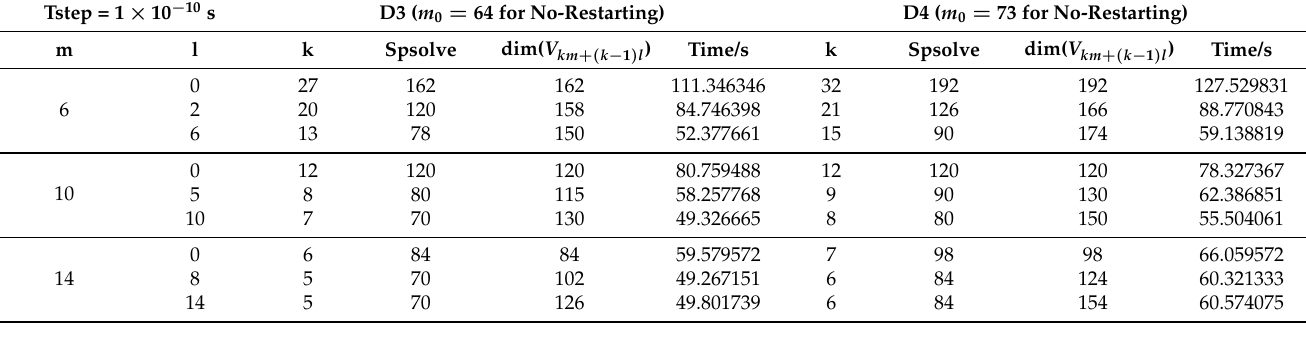
Table 4. Performance data of D3 and D4.